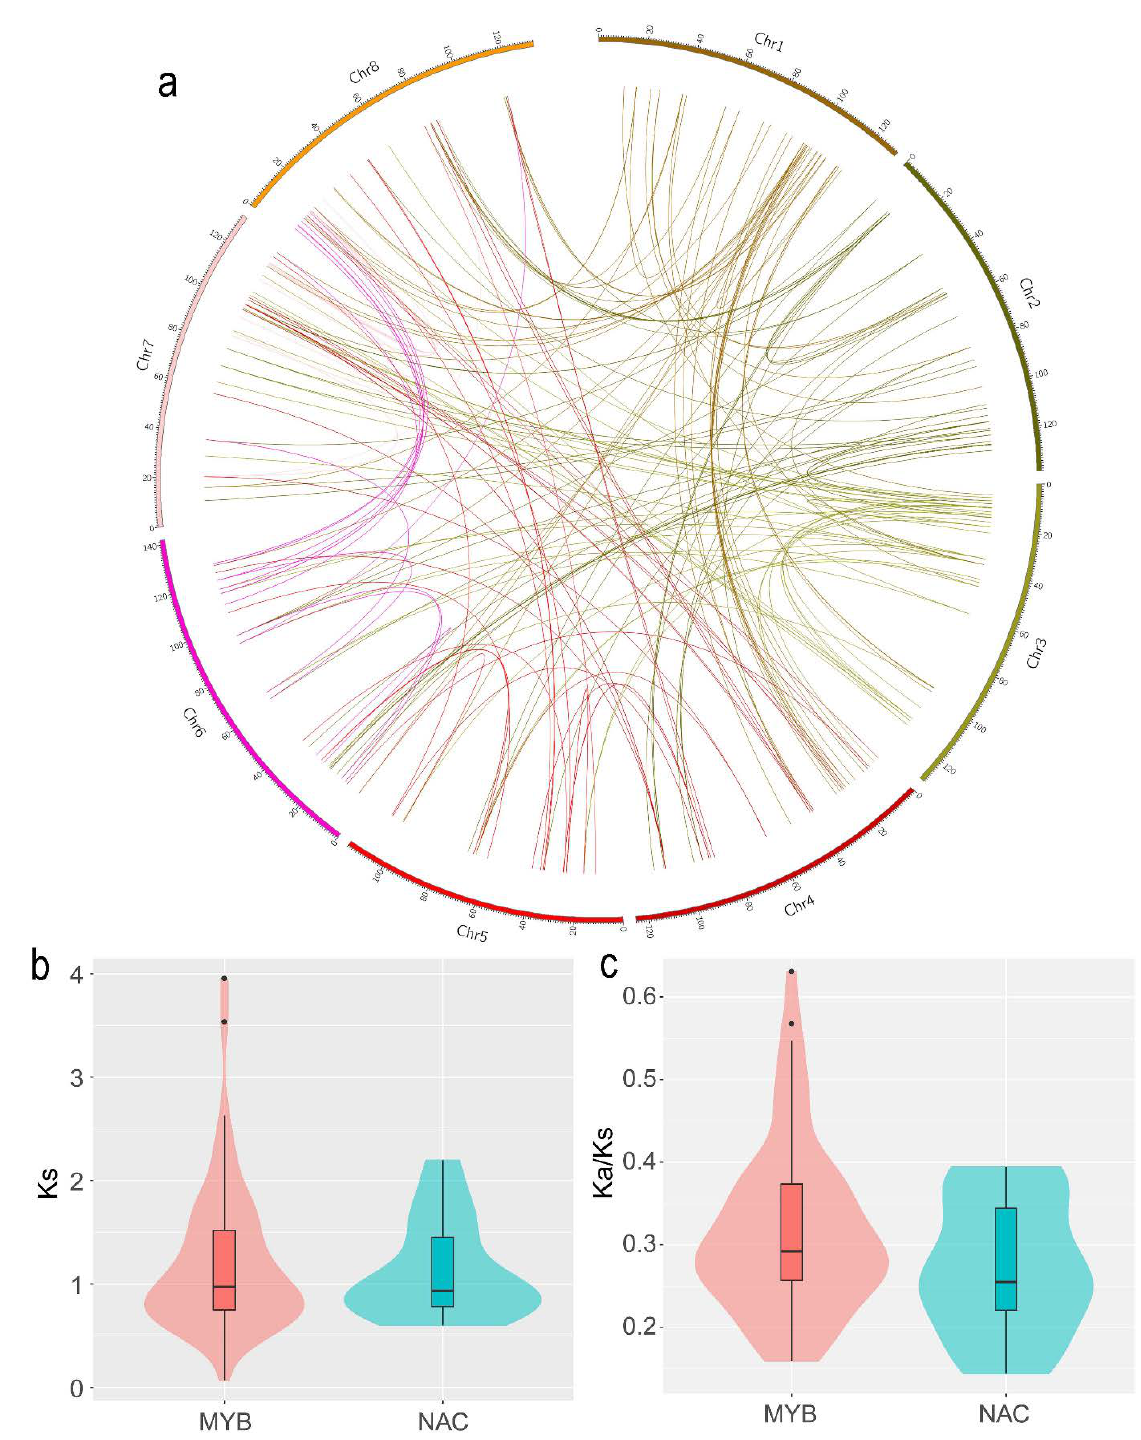
Figure 2. Synteny analysis of MaNAC and MaMYB gene pairs. ( a ) Synteny of MaNAC and MaMYB paralogs in M. albus. ( b ) Ks value of MaNAC and MaMYB paralogs. ( c ) Ka/Ks value of MaNAC and MaMYB paralogs.